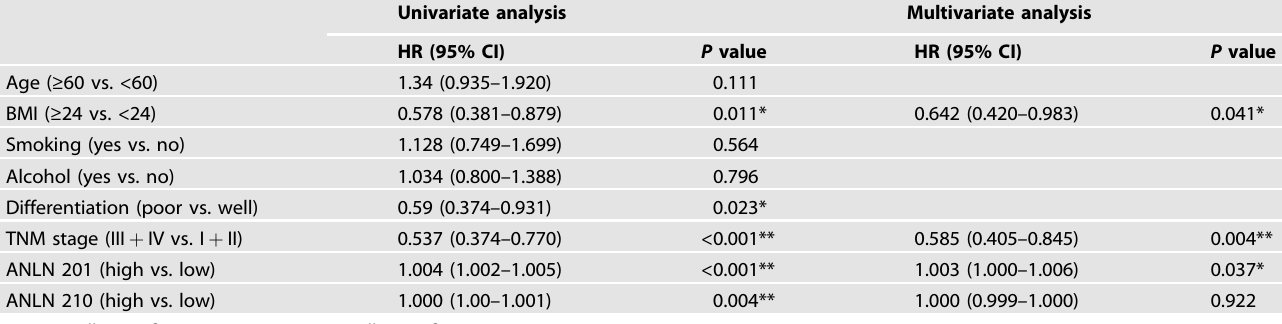
Table 1. Cox proportional hazard models for prognostic